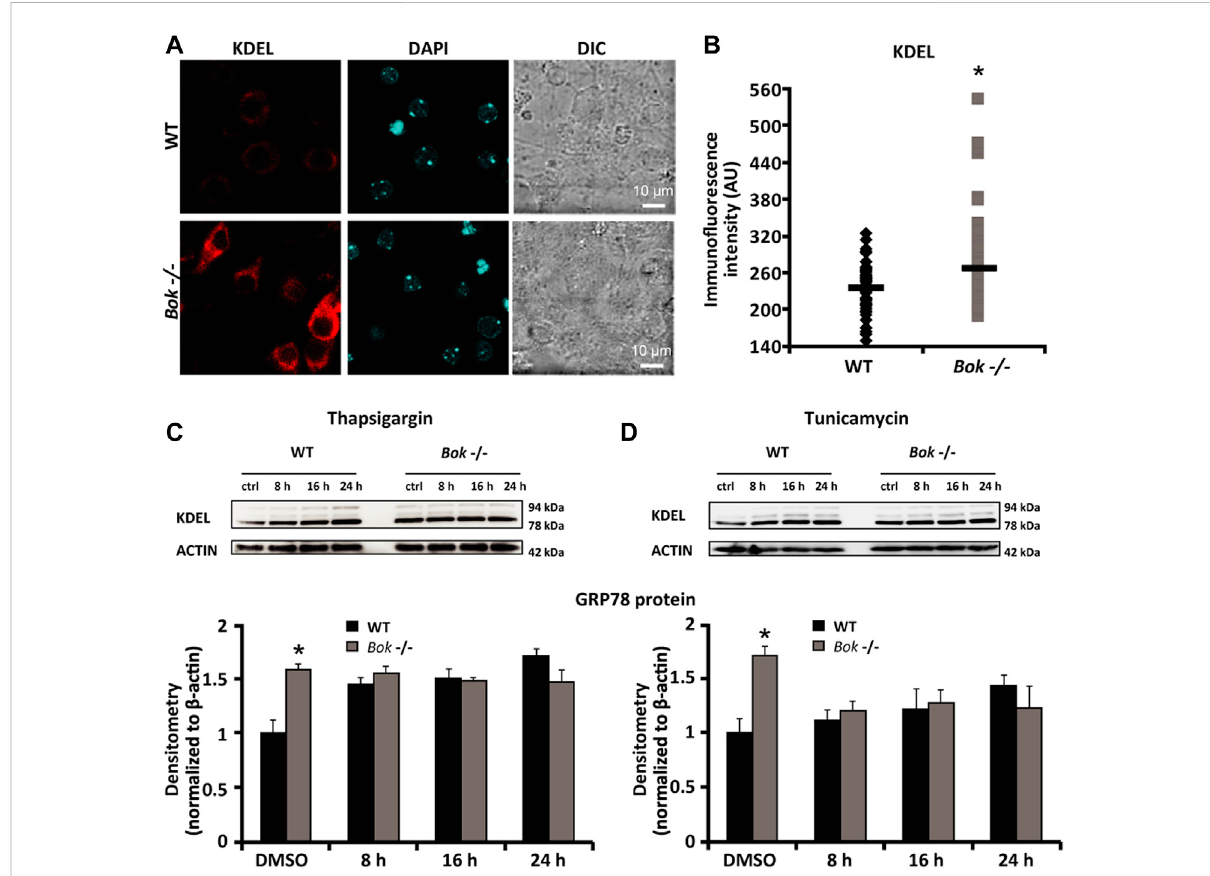
FIGURE 1 Bok -de fi cient neurons display higher basal ER stress. (A,B) Cortical neurons from WT and Bok − / − mice were stained for KDEL, an ER marker. Differential interference contrast (DIC), KDEL, and DAPI fl uorescent images were captured from random fi elds using confocal fl uorescence microscopy and chosen from a representative experiment [ (A) , scale bar = 10 μ m]. Analysis of basal KDEL levels (B) quanti fi ed as mean fl uorescence intensity in WT ( n = 54) and Bok − / − ( n = 62) neurons is represented. A signi fi cant increase in the whole-cell KDEL fl uorescence of the Bok − / − neurons was identi fi ed. * indicates statistical signi fi cance ( p ≤ 0.05). p -value = 0.014 vs . WT cultures (Student ’ s t-test). (C,D) Western blot and densitometry analysis comparing the levels of GRP78 protein using a KDEL antibody in WT and Bok − / − cortical neurons either treated